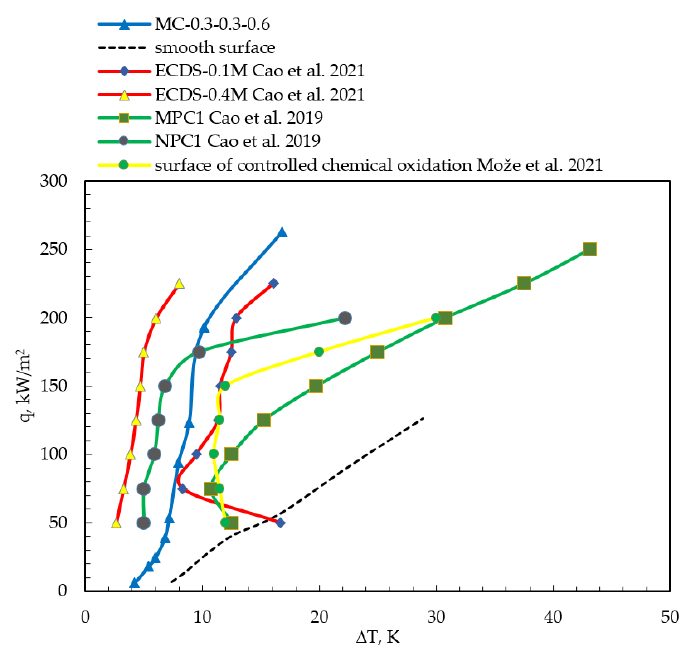
Figure 9. Comparison of pool boiling curves for 0.3 mm wide microchannels with boiling curves from surfaces with microparticle coating (MPC) [25], nanoparticle coating (NPC) [25] and microporous coatings (electrochemical deposition method—ECDS) [24], and the surface of controlled chemical oxidation [38].